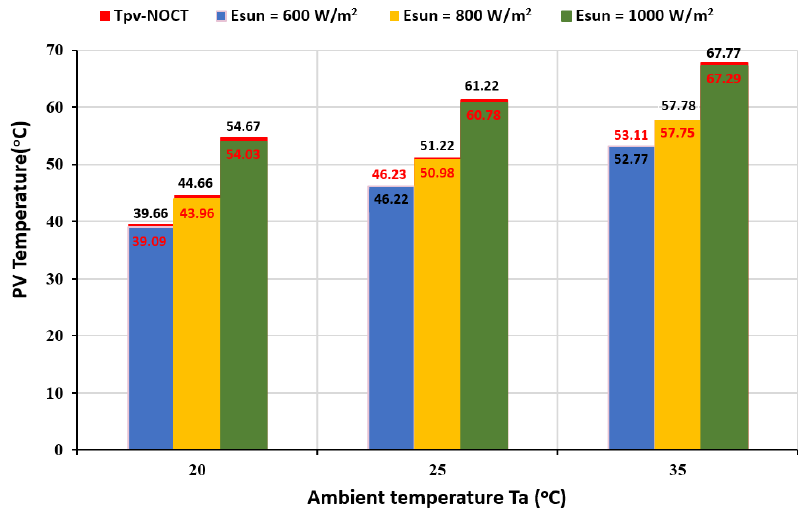
Figure 3. Comparison of the developed PV model and NOCT model.